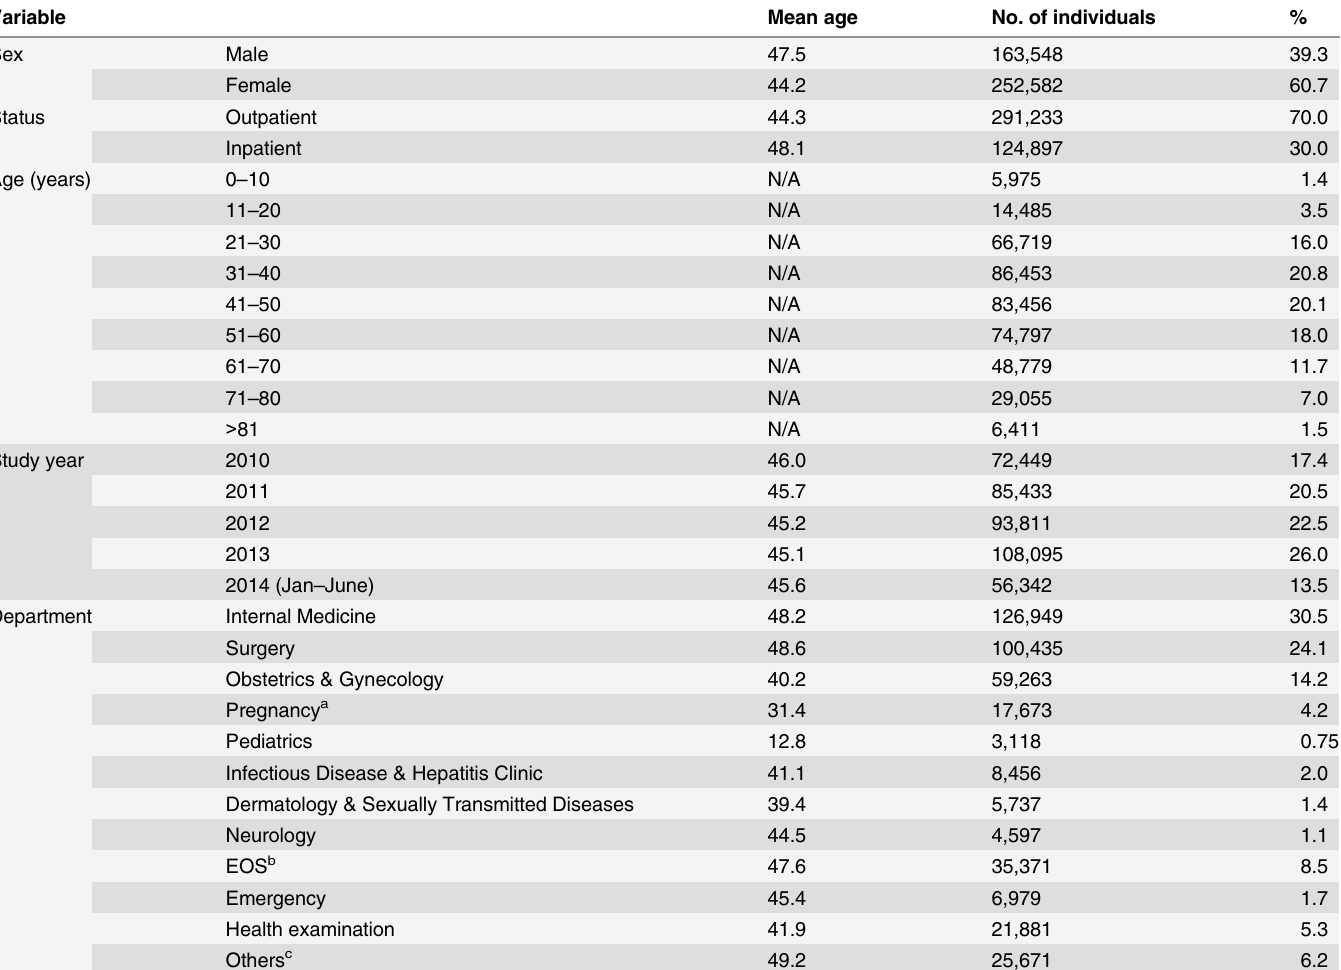
Table 1. Characteristics of Chinese Subjects who were Screened at Peking Union Medical College Hospital (2010 – 2014, n =